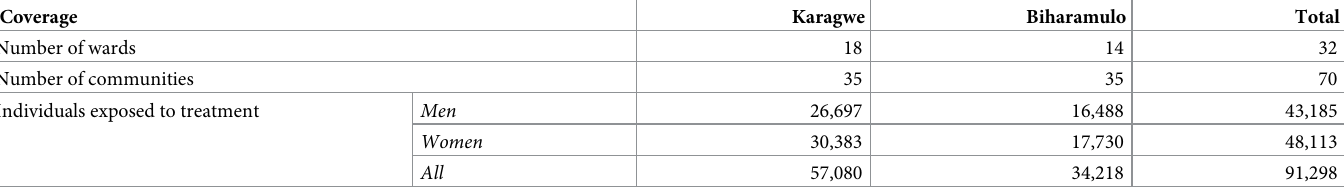
Table 4. CGLAS: Coverage of paralegal land advisory services programme in